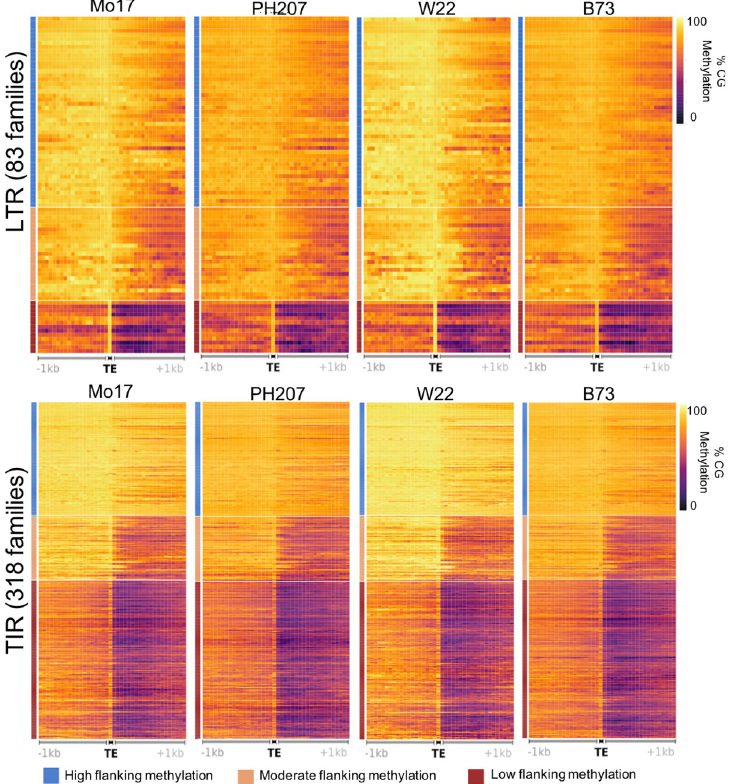
Fig 3. Consistency of methylation profiles surrounding TEs in different maize inbreds. For 83 LTR families and 318 TIR families that have at least 20 non-nested members in all four genotypes the metaprofile of CG DNA methylation was determined. The order of families was kept the same as in Fig 2, although a subset of the families were omitted as they did not have 20 members in at least one other genotype. The DNA methylation levels were determined based on the alignment of WGBS to the genome assembly from which it was derived and using the elements annotated within that genome. Very similar consistent patterns are also observed using CHG methylation profiles.